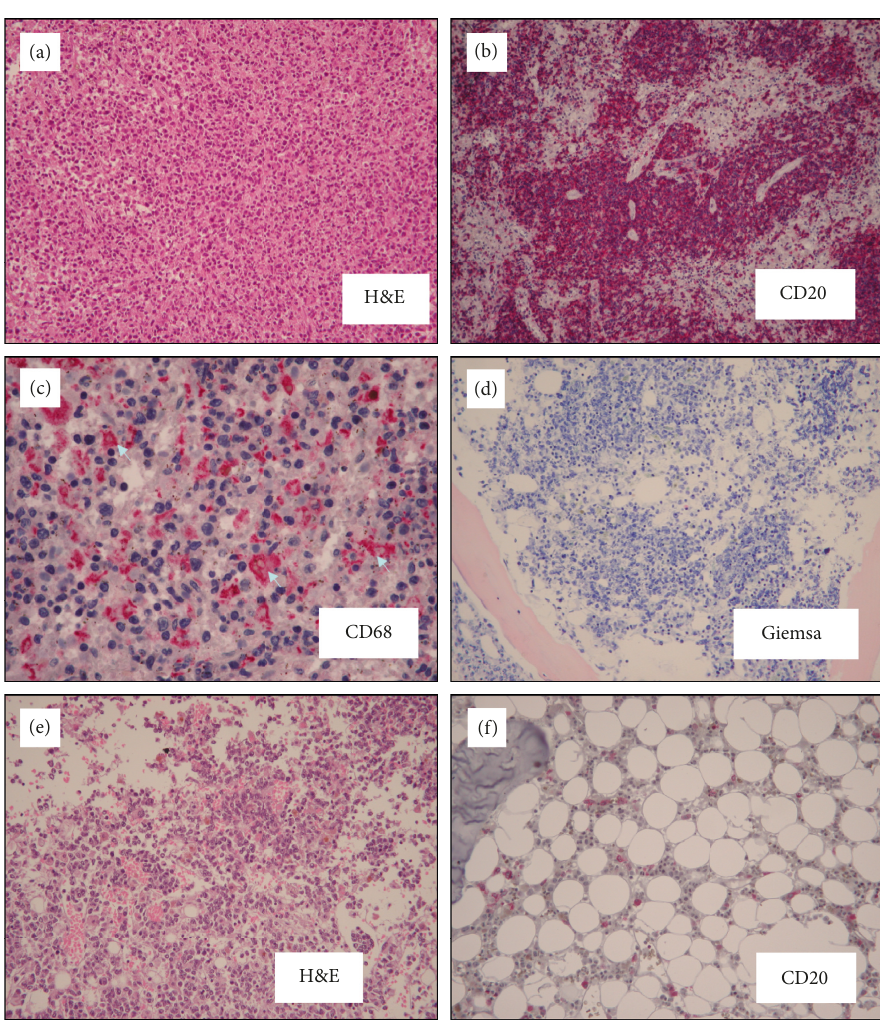
Figure 2: Microscopic appearance of IVLBCL infiltrating the spleen (a–c) and the bone marrow (d–f). Hemophagocytosis (light blue arrows) was observed in the spleen (c). H&E � hematoxylin and